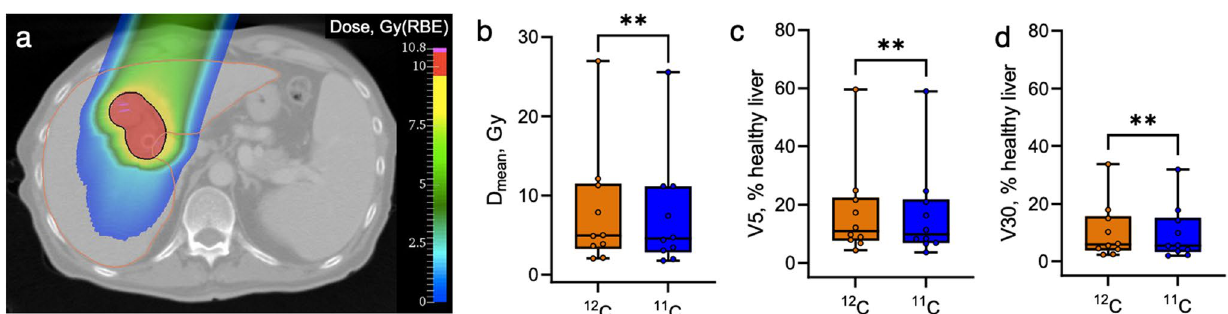
Figure 3. Treatment outcomes planning for the liver tumor patients. ( a ) Example of the single-field dose distribution and planning contours. Black – tumor CTV, brown – liver. Color bar represents the dose distribution (red color corresponds to the prescribed CTV dose of 10 Gy(RBE)). ( b ) Total mean dose to the healthy liver (liver – GTV). ( c ) Relative volumes of healthy liver, receiving the total dose of at least 5 Gy (V5). ( d ) Relative volumes of healthy liver, receiving the total dose of at least 30 Gy (V30). Points represent the single patient median values among 21 uncertainty scenario (10 patients in total). Orange color: 12 C plans, blue color: 11 C plans. Stars represent the result of the Wilcoxon Signed-Rank test ( P = 0.002) for all